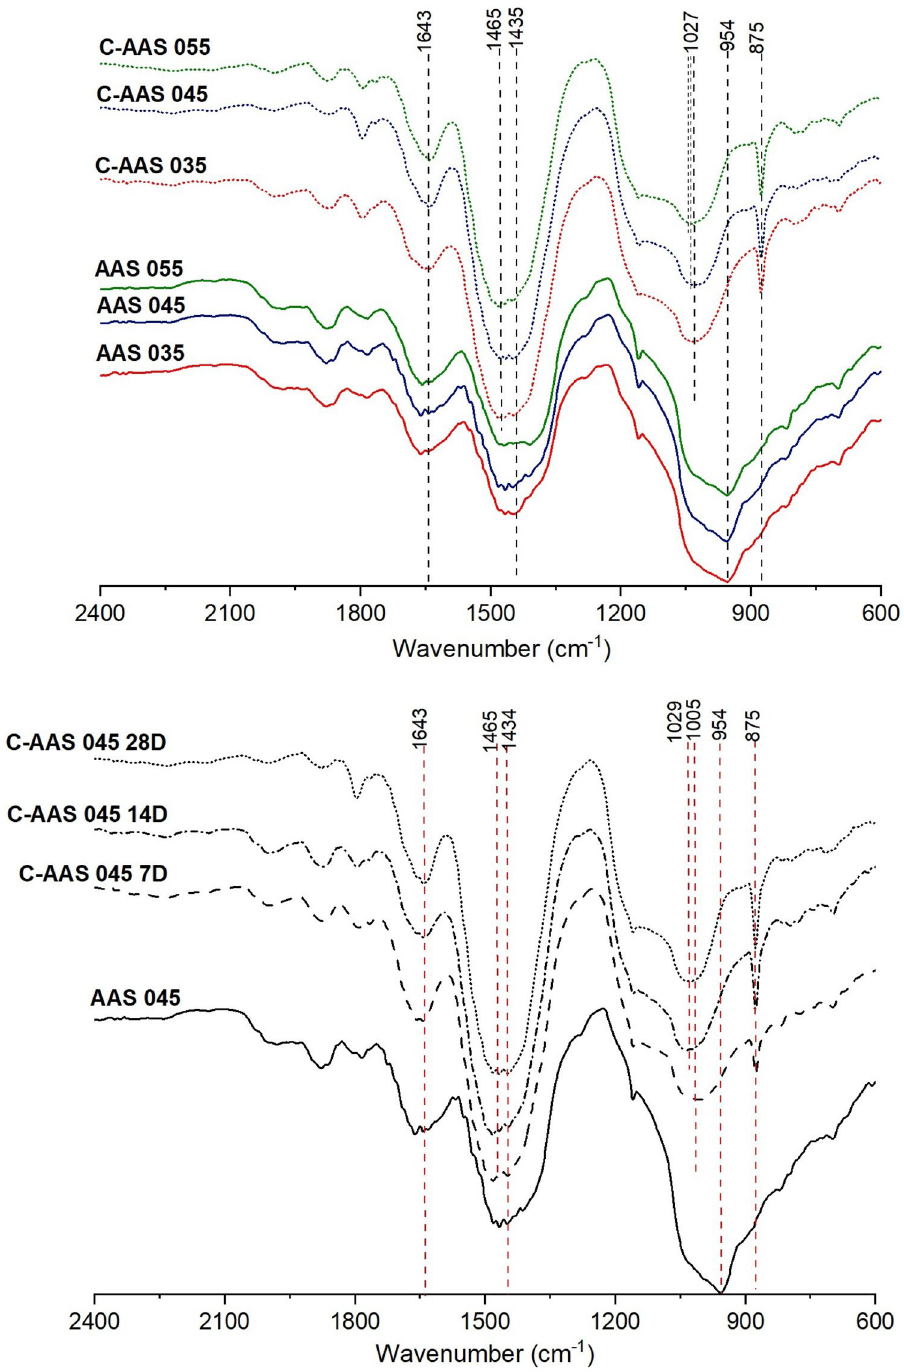
Figure 4. FTIR spectra of uncarbonated (AAS), 28-day carbonated alkali activated slag (C-AAS) at different w/b ratios (top) and C-AAS with w/b ratio of 0.45 (C-AAS 045) at 7, 14 and 28 days of carbonation